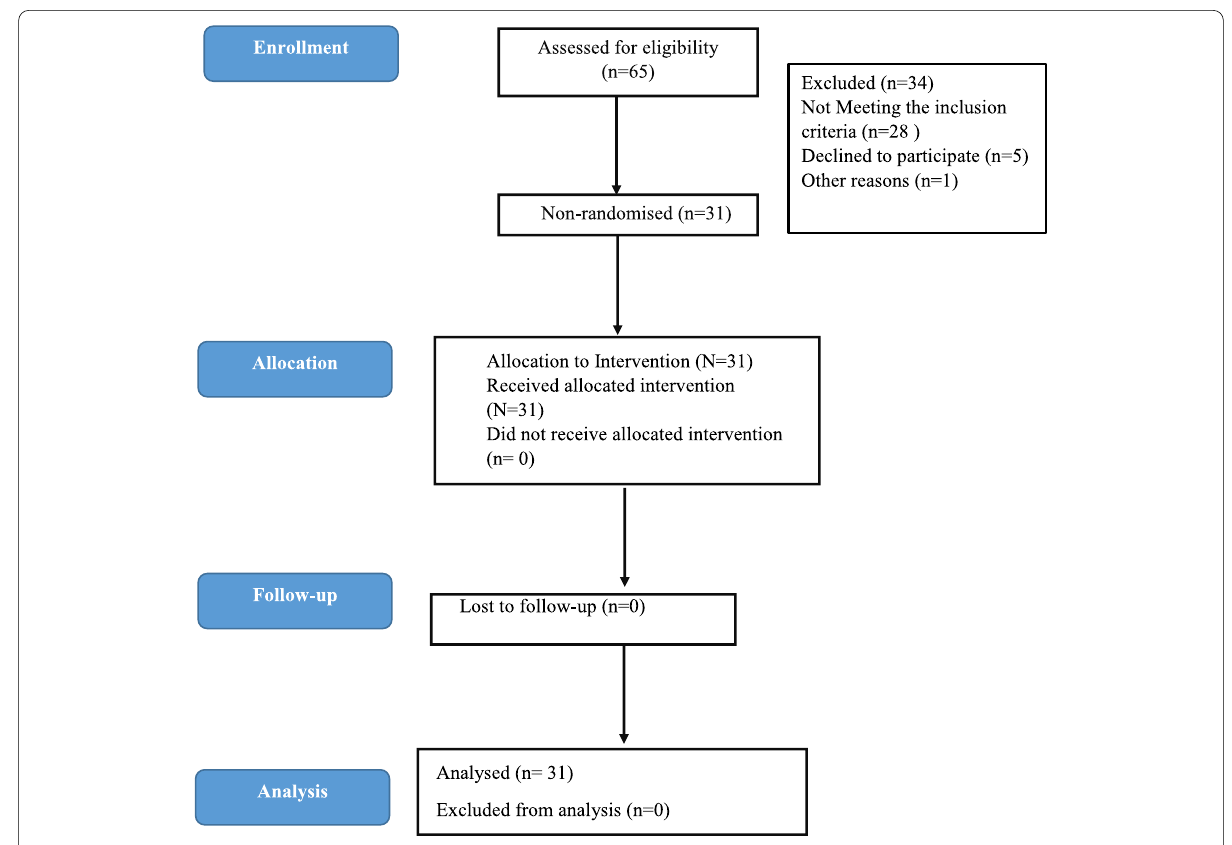
Fig. 1 Flow chart of the Transparent Reporting of Evaluations with Nonrandomized Designs